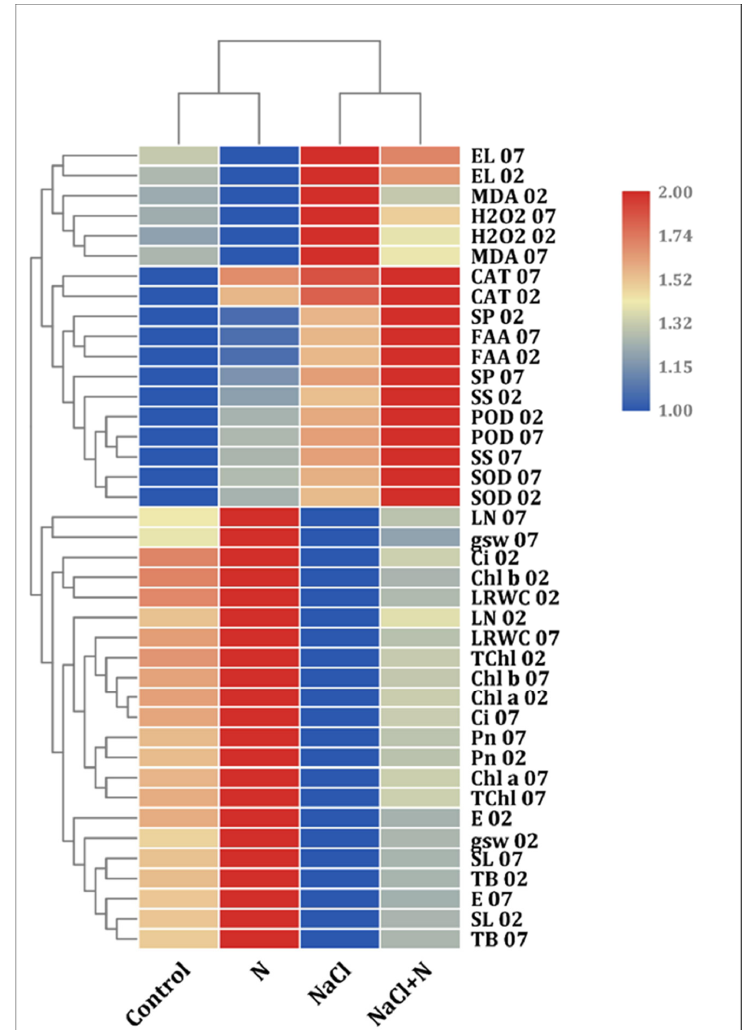
Figure 9. Heat map showing different morpho-physiological traits of cotton genotypes according to different treatments. Measured traits are arranged in rows and columns represents different treatments.